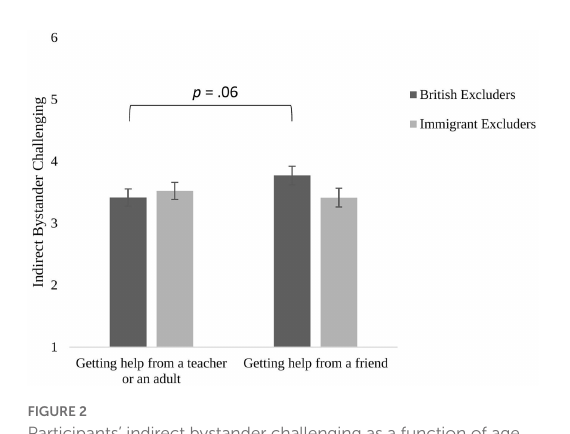
FIGURE 2 Participants’ indirect bystander challenging as a function of age group membership of the excluder. Error bars show standard